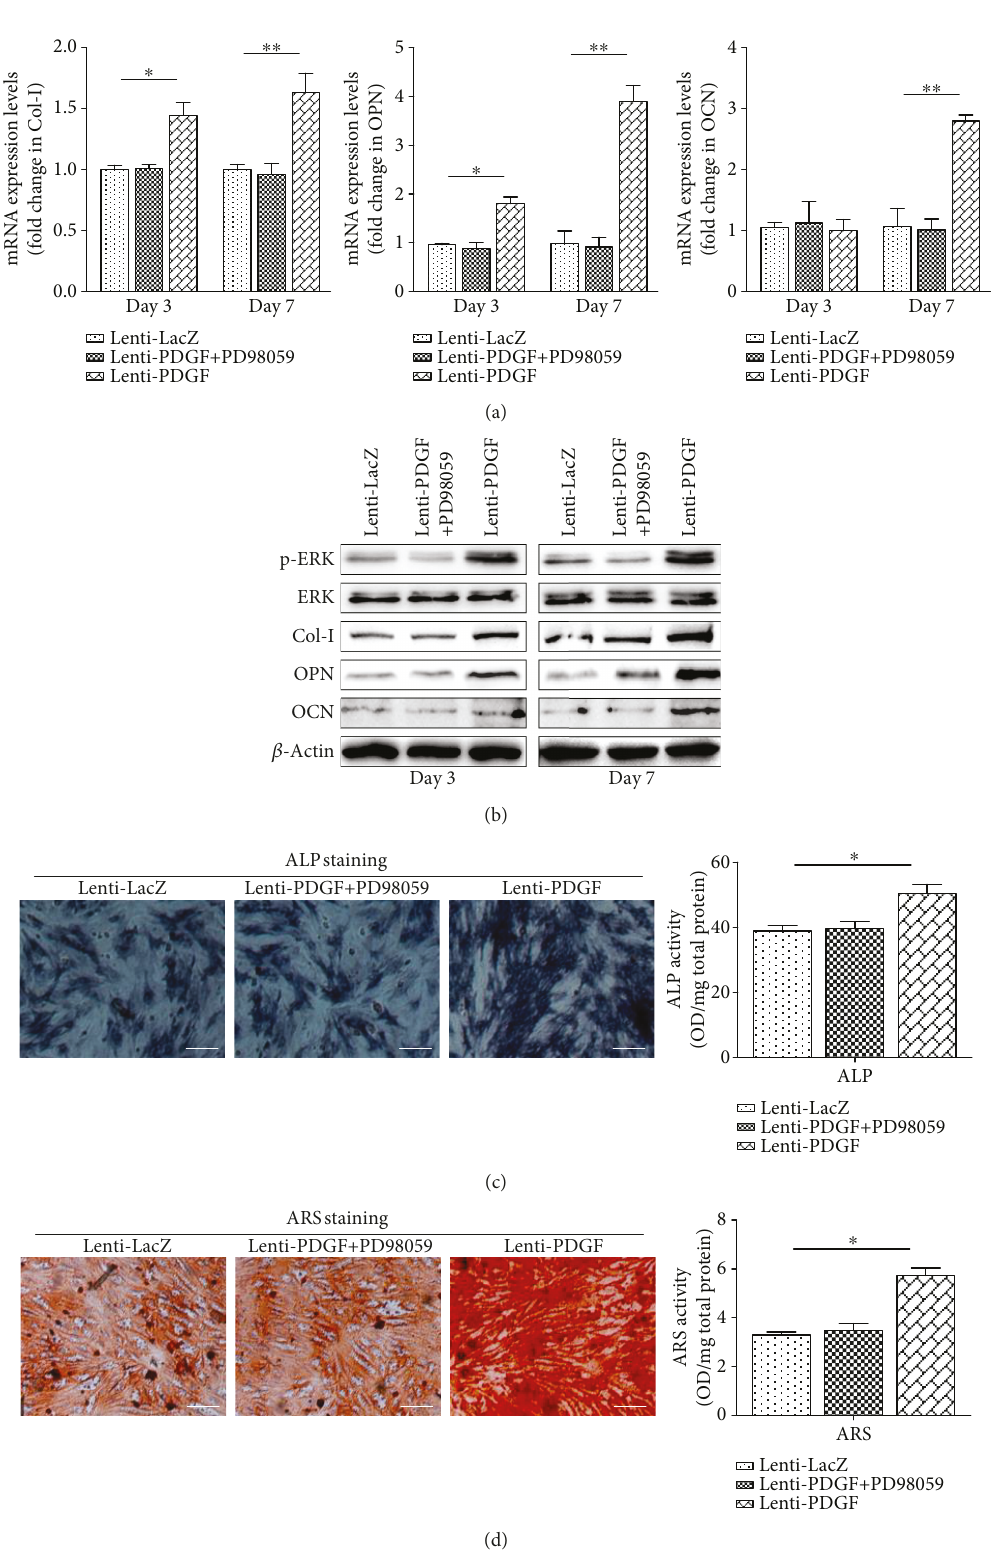
Figure 2: PDGF-BB enhanced BMSC osteogenic di ff erentiation via ERK1/2 signaling pathways. (a) mRNA expression levels of Col-I , OPN , and OCN on days 3 and 7. (b) Protein expression levels of p-ERK, ERK, Col-I, OPN, and OCN on days 3 and 7. (c) ALP staining and semiquantitative analysis of ALP activity. (d) ARS staining and semiquantitative analysis of ARS staining. ALP: alkaline phosphatase; ARS: alizarin red S. Scale bar: 100 μ m; ∗ P < 0 05 ; ∗∗ P < 0 01